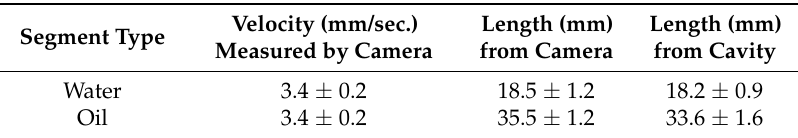
Figure 13. RMC perturbations due to a segmented oil: water flow. ( a ) resonant frequency (water = low frequency); ( b ) bandwidth (water = high bandwidth); and ( c ) insertion loss (water = high loss). Table 3. Water and oil segment length measured by camera and RMC.